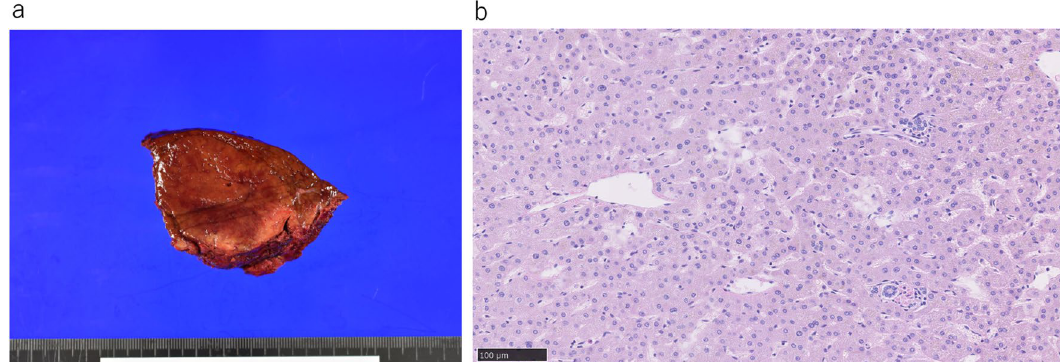
Fig. 2 Resected specimen and pathological findings. Observation of the resected specimen revealed that the tumor was yellow to brown with a well-defined border ( a ). In the histopathological examination, the lesion was 70 mm in diameter. There were no malignant findings in hepatocytes. In general, the portal region consists of three elements: the artery, portal vein and bile duct. However, in the portal region of this case, where the tumor was located, these components were absent and scattered small blood vessels were observed. Scale bar 100 µm ( b